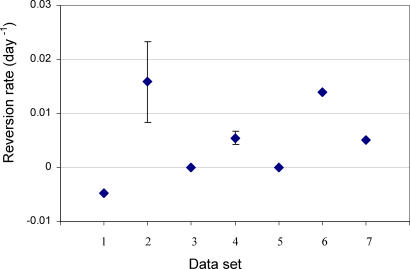
Reversion Rate EstimatesBest (filled diamonds) estimates of the reversion rate in each of the seven datasets. Best estimates are shown ±1 standard error. Escape and reversion may require additional compensatory mutations which will limit the occurrence of escape or reversion and will delay the time until escape or reversion occurs. The effect of such compensatory mutations (even if they occur outside of the epitope) will be fully quantified because their effect will be reflected in the rate of escape/reversion of the variant. It is also possible that compensatory mutations will be acquired after the wild-type has been completely replaced by the escape variant. Interestingly, escape 7 and reversion 5 are “paired.” That is, the outgrowth of the escape variant labeled 7 was observed in one individual (the “donor”) who transmitted the escape variant to their sexual partner (the “recipient”), and in whom the escape variant then reverted (reversion 5). Outgrowth of the escape variant was observed in the donor during the time at which the recipient was infected. Both the escape and reversion rates are typical and lie within the range of the other observed escape/reversion rates, implying that low reversion rates cannot be attributed to the accumulation of compensatory mutations following escape.